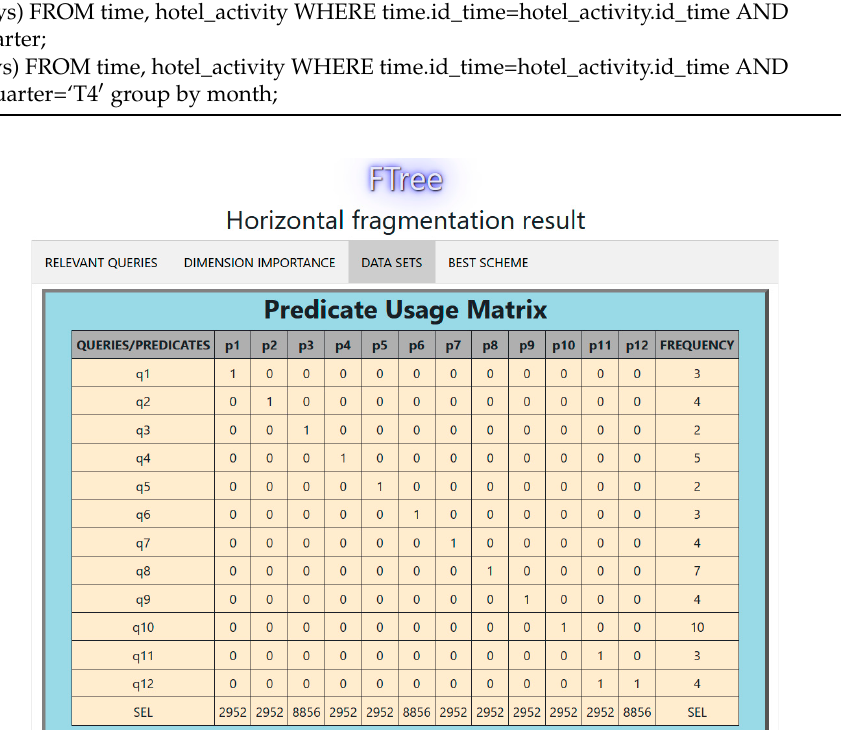
Figure 8. PUM for the second experiment with the tourist DW.